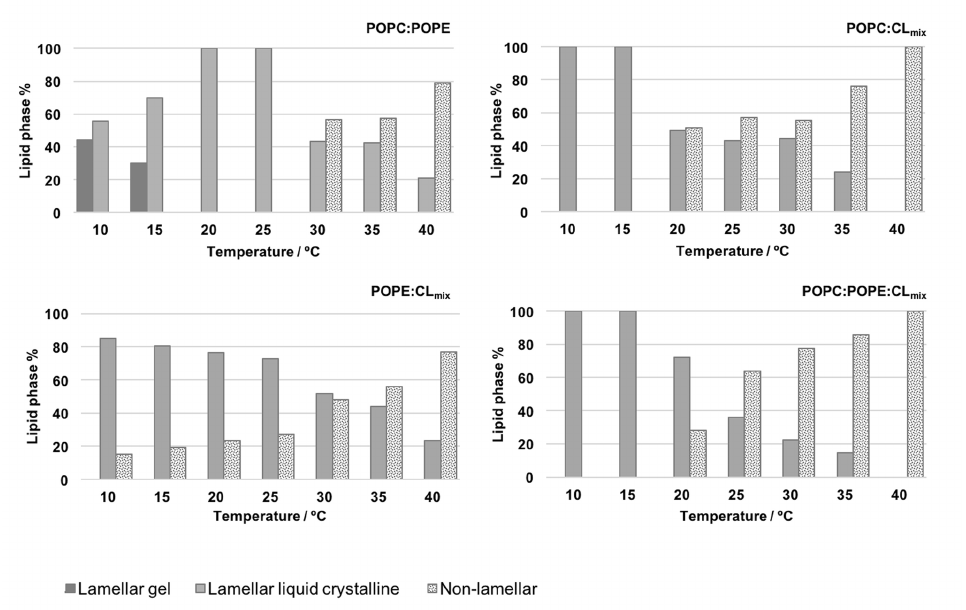
Figure 11. Relative quantitative distribution of different lipid phases as function temperature of POPC/POPE (0.5:0.5), POPC/CLmix (0.7:0.3), POPE/CLmix (0.6:0.4) and POPC/POPE/CLmix (0.5:0.3:0.2) in the studied temperature range. pH 7.4, 0.1 mM NaCl. Reproduced with